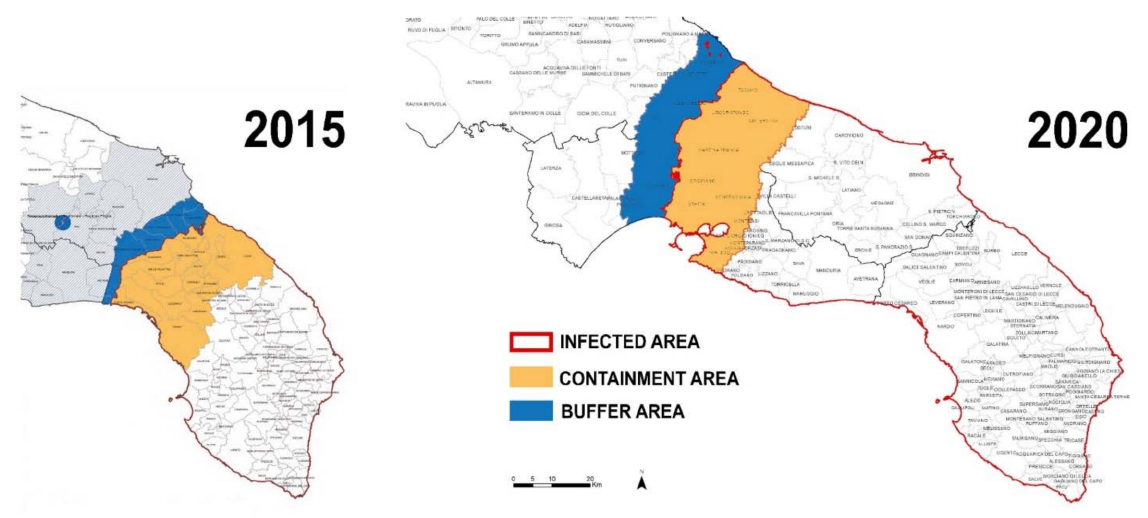
Figure 1. Map showing the spreading of Xylella fastidiosa in the Salento peninsula (adapted from [14,15] with